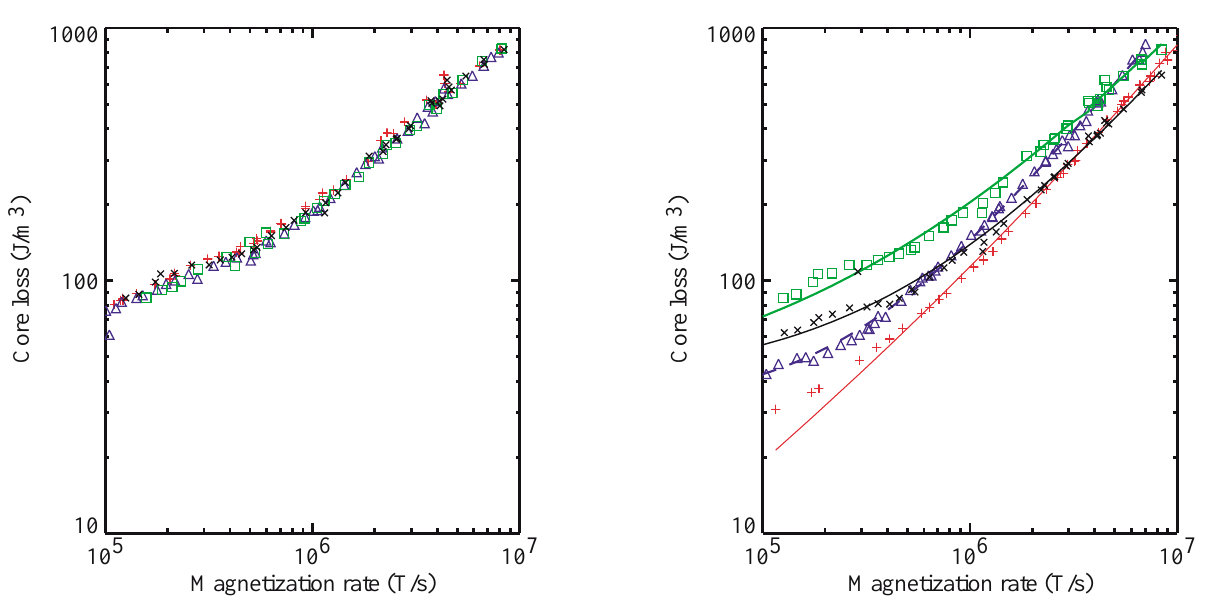
FIG. 19. (Color) Core loss versus magnetization rate for four FINEMET FT-2H higher flux-swing nanocrystalline cores, manufactured by Hitachi.